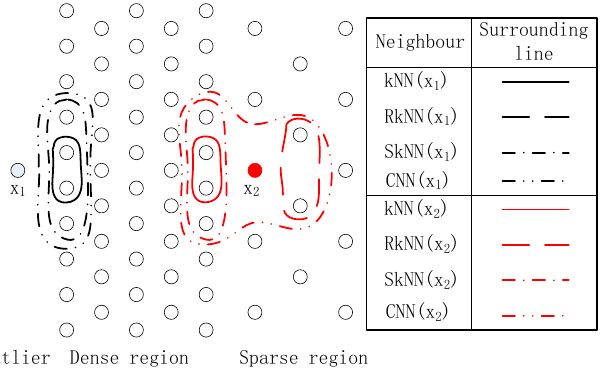
Figure 1. Local neighbors in different data distributions.